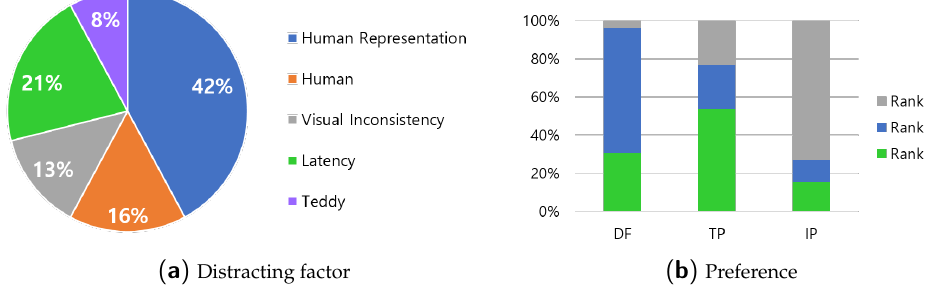
Figure 6. Results of the distracting factors and preference